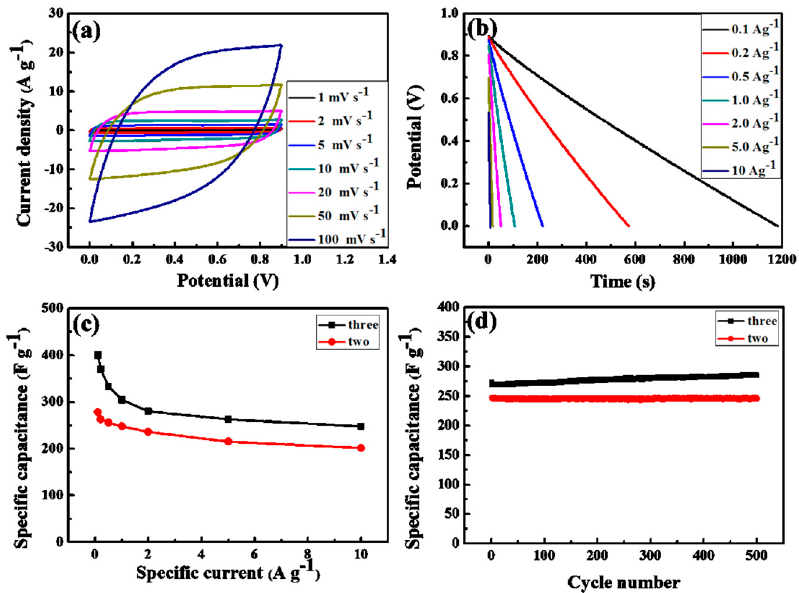
Figure 7. Electrochemical performance of the HPC-800 electrode measured in a two-electrode system: ( a ) CV curves at different various scan rates; ( b ) GCD curves under different current densities; ( c ) capacity profiles at different current densities; ( d ) the long cycle life over 500 cycles at a current density of 1 A·g − 1 .